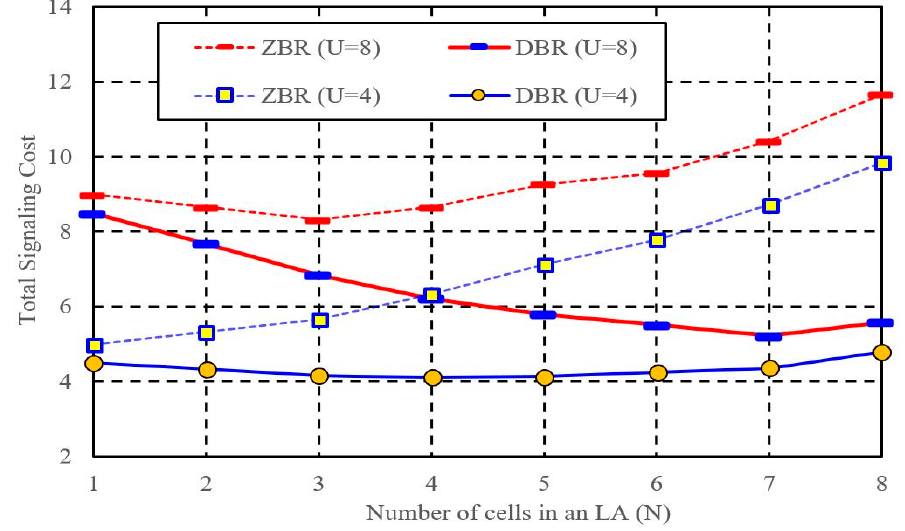
Figure 15. Performance comparison results of DBR and ZBR (CMR = 1).